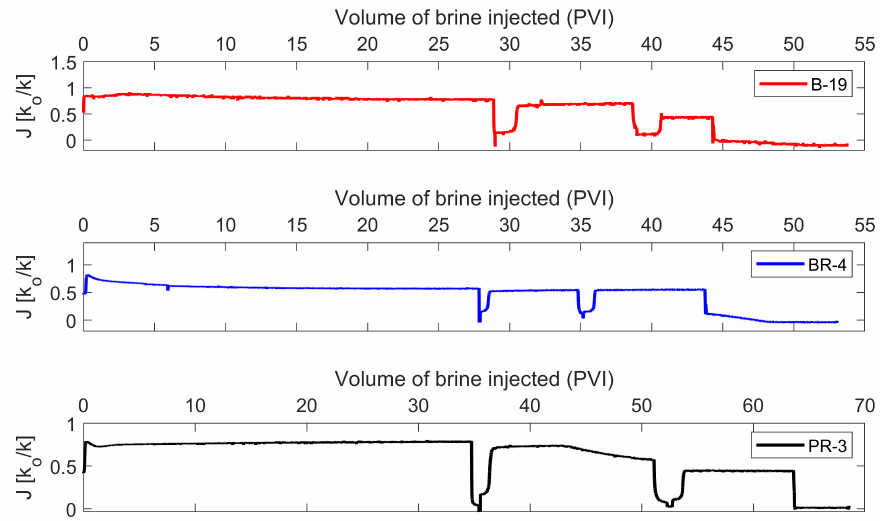
Figure 4. The impedance change for 2D*TB EDTA into Berea (red line), Bandera Brown (blue line), and Parker (black line) sandstones.